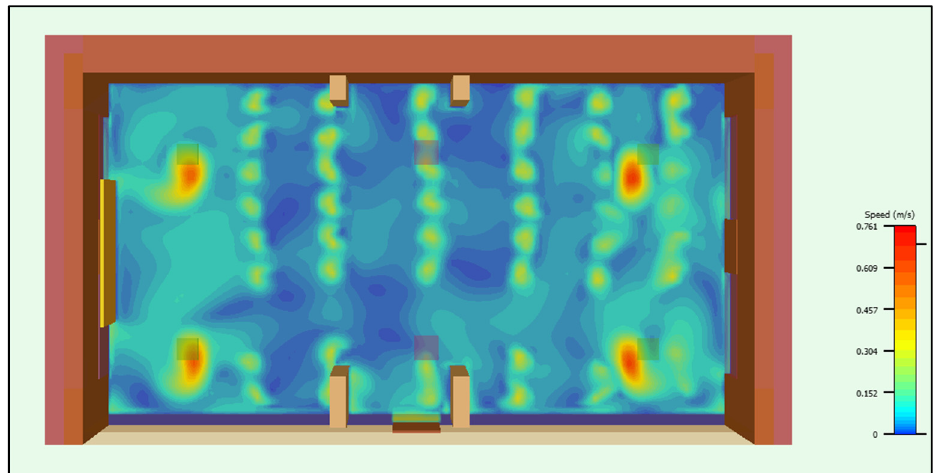
Figure 12. Distribution of the air velocities in a floor-parallel plane at the height of about 1.5 m; situation for the full room at 3:00 PM—the mechanical air conditioning.